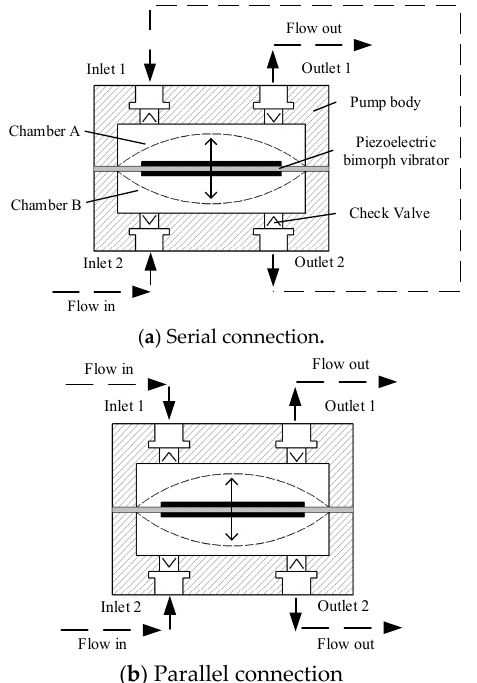
Figure 1. Schematic cross-section and connection mode of a dual-chamber serial-parallel piezoelectric pump with an integrated sensor (DSPPIS) .